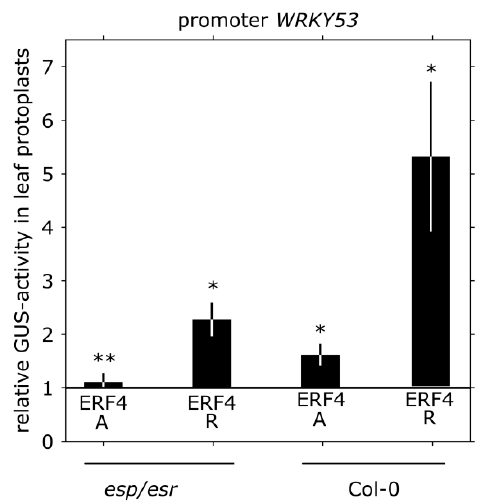
Figure 4. Impact of ERF4 on WRKY53 expression. Transient expression assays were performed in Arabidopsis protoplasts with a 2.8 kbp fragment of the WKRY53 promoter that drives expression of GUS in Col-0 and esp/esr mutant leaf protoplasts. Values represent fold-change of GUS-activity relative to the empty vector after normalization to luciferase activity from a minimum of four experiments. Error bars indicate ± SE. Statistical differences were determined by one sample t-test (* p ≤ 0.05, ** p ≤ 0.005, *** p ≤ 0.0005).